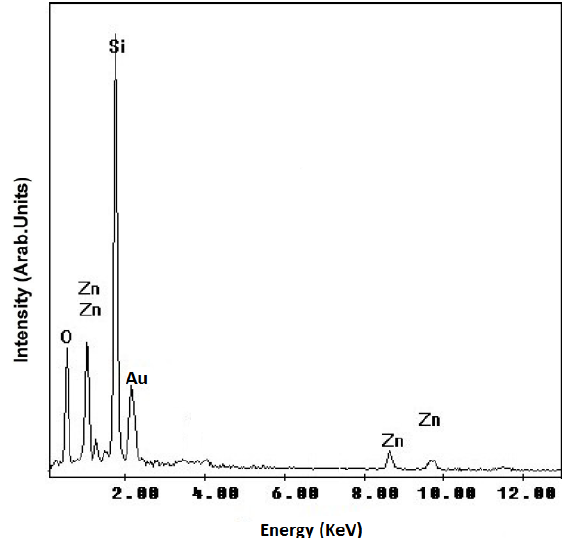
Figure 4. EDX spectrum measured for ZnO nanowires prepared by the oxidation of Zn thin films at a temperature of 600 °C.